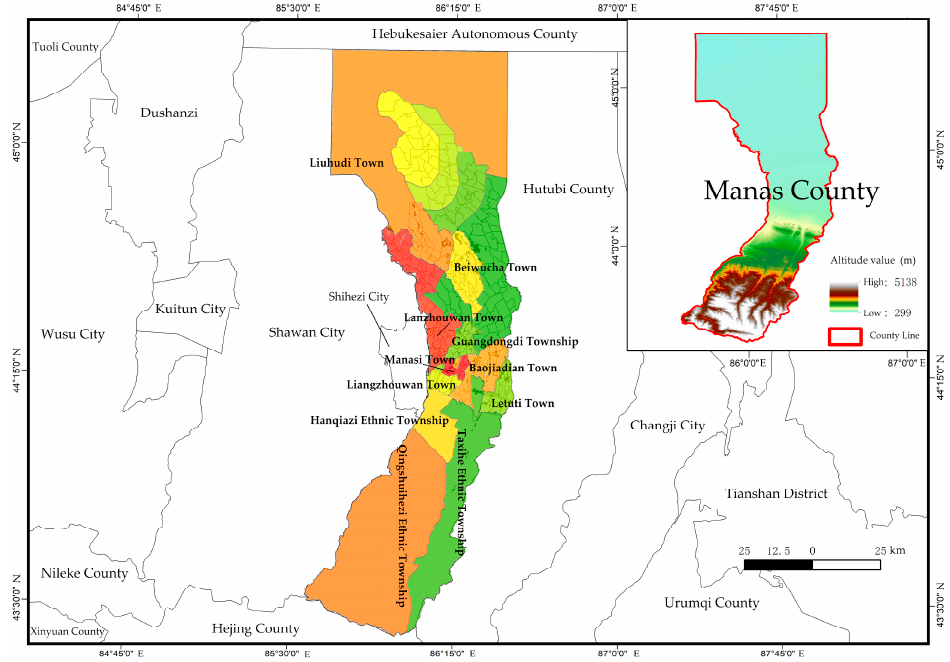
Figure 1. Spatial distribution of Manas